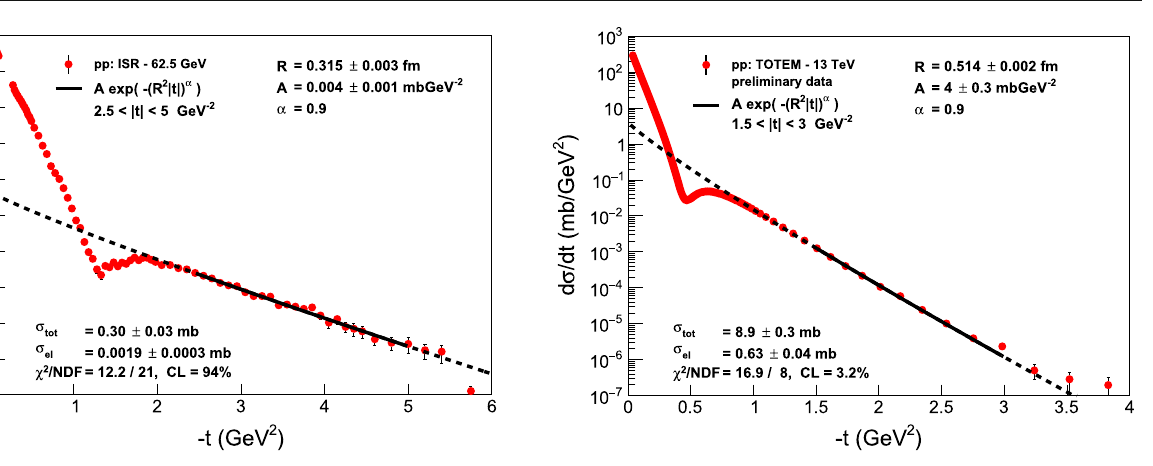
√ s = 13 TeV (TOTEM pre-